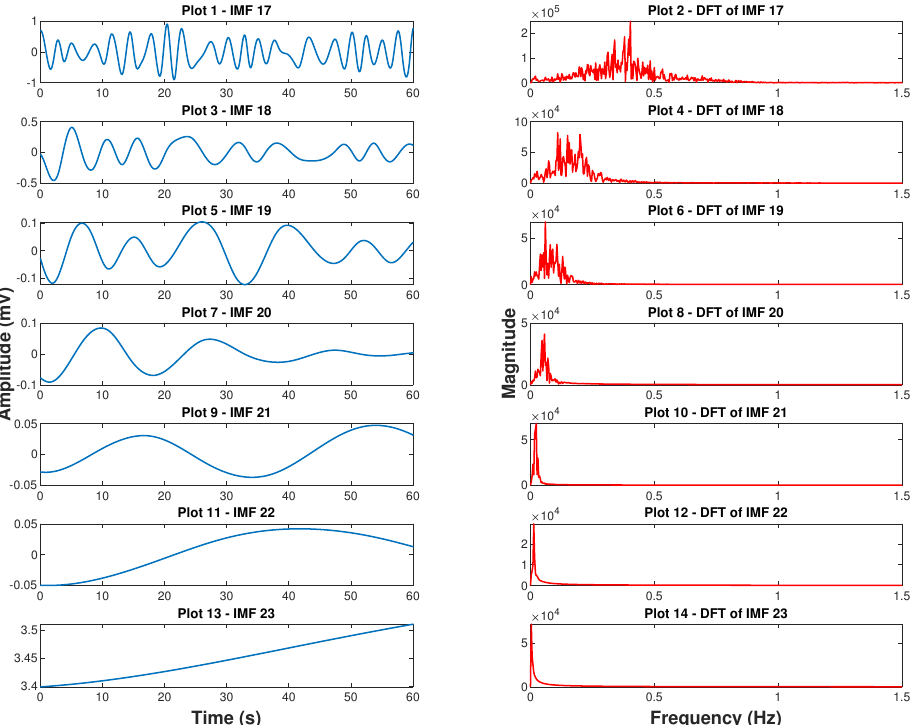
Figure 4. DFT analysis of the IMFs 17 to 23 of b001: The plots on the left column depict IMFs 17 to 23. The plots on the right column show the corresponding spectra (DFT points =